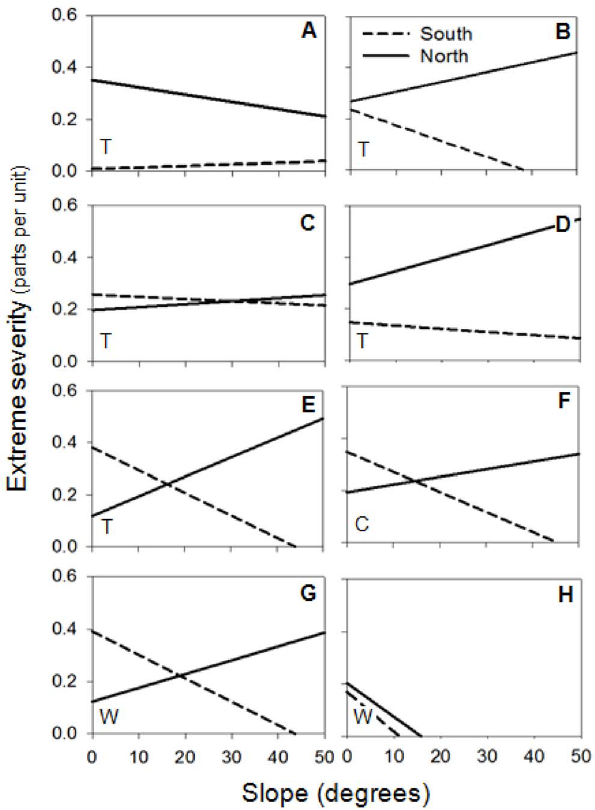
Figure 2. Significant interactions of Aspect (north or south) and Slope (degrees) on extreme fire severity (parts per unit). Letters in the top-right corner indicate the fire: (A) Bot 2000; (B) Castellbell i el Vilar 2003; (C) Castellbisbal 2005; (D) Vimbodı´ 2006; (E) Nava`s 2007; (F) Castellnou de Bages 2005; (G) Cistella 2006; (H) Mont- roig del Camp 2007. Letters in the bottom-left corner indicate the fire type: (T) topographic fires; (C) convective fires; (W) wind-driven fires.